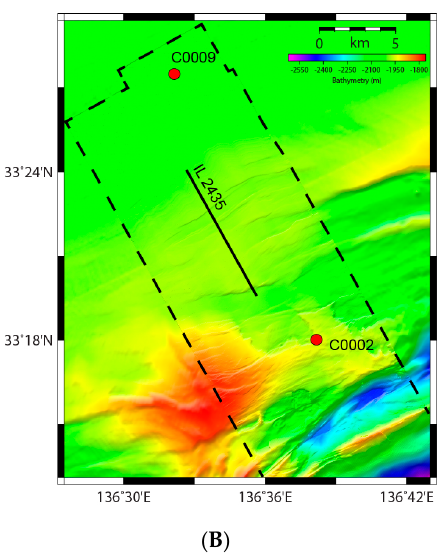
Figure 6. ( A ) Inline 2435 showing representative cross section through the Upper BSRs in Zone-1. Note termination pattern against the normal faults, a strong BSR (interpreted blue line) and indicators of gas beneath. ( B ) Bathymetric map of the study zone with the extent of IL 2435 shown for reference.